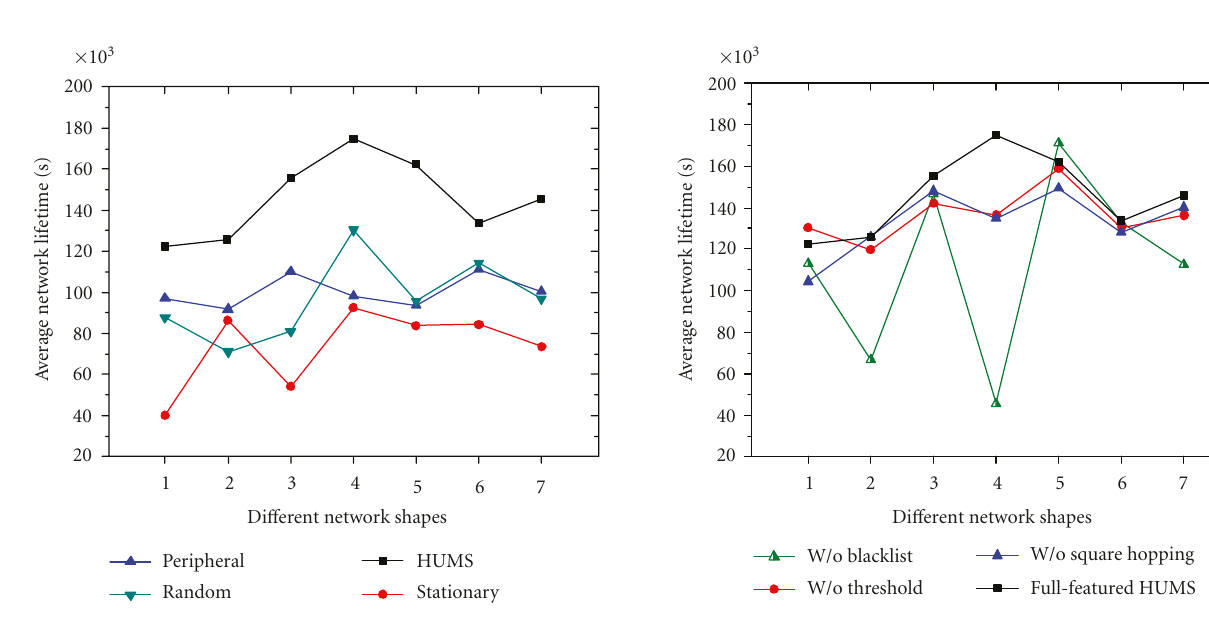
Figure 13: Network lifetimes of the variations of HUMS when cut- ting o ff di ff erent features. (The initial energy for each node is